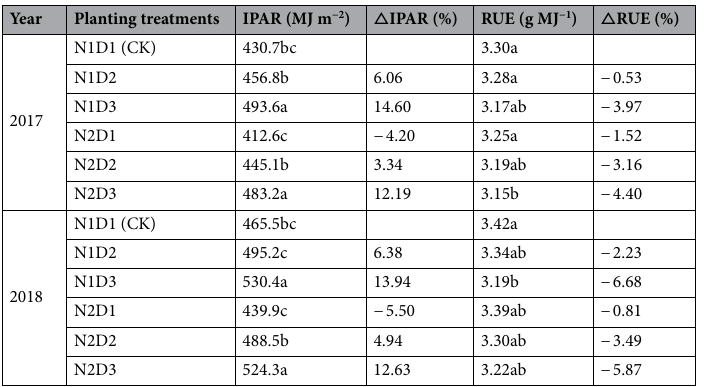
Table 3. Cumulative intercepted photosynthetically active radiation (IPAR), and radiation use efficiency (RUE) of maize in four planting treatments in 2017 and 2018. Values followed by different letters within a column are significantly different ( P < 0.05). ΔIPAR and ΔRUE change of IPAR and RUE in the planting treatments in relation to the CK.